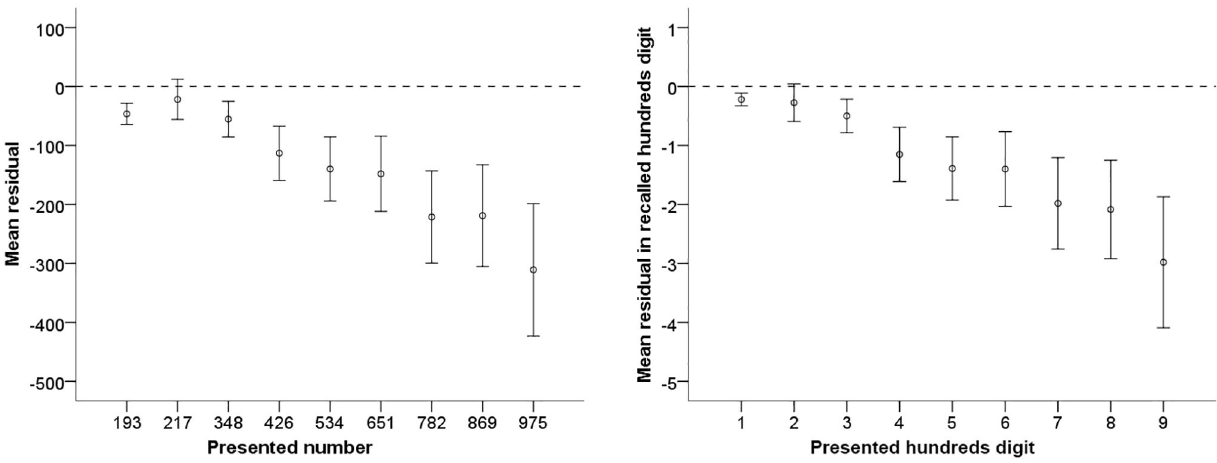
Figure 2. 95% confidence intervals for mean residuals (left) and mean residuals in the leading digit (right) in Study 1. Testing Predictions About the Relation Between the Standard Deviation of Residuals and Other